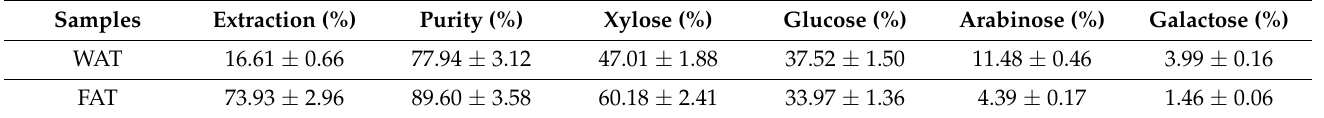
Table 2. Extraction yield and purity of hemicellulose obtained by different treatments.